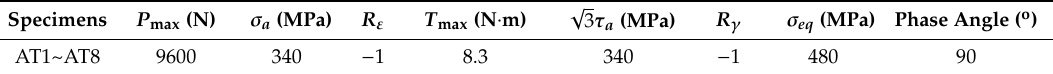
Table 2. Test conditions of low-cycle fatigue under axial-torsion